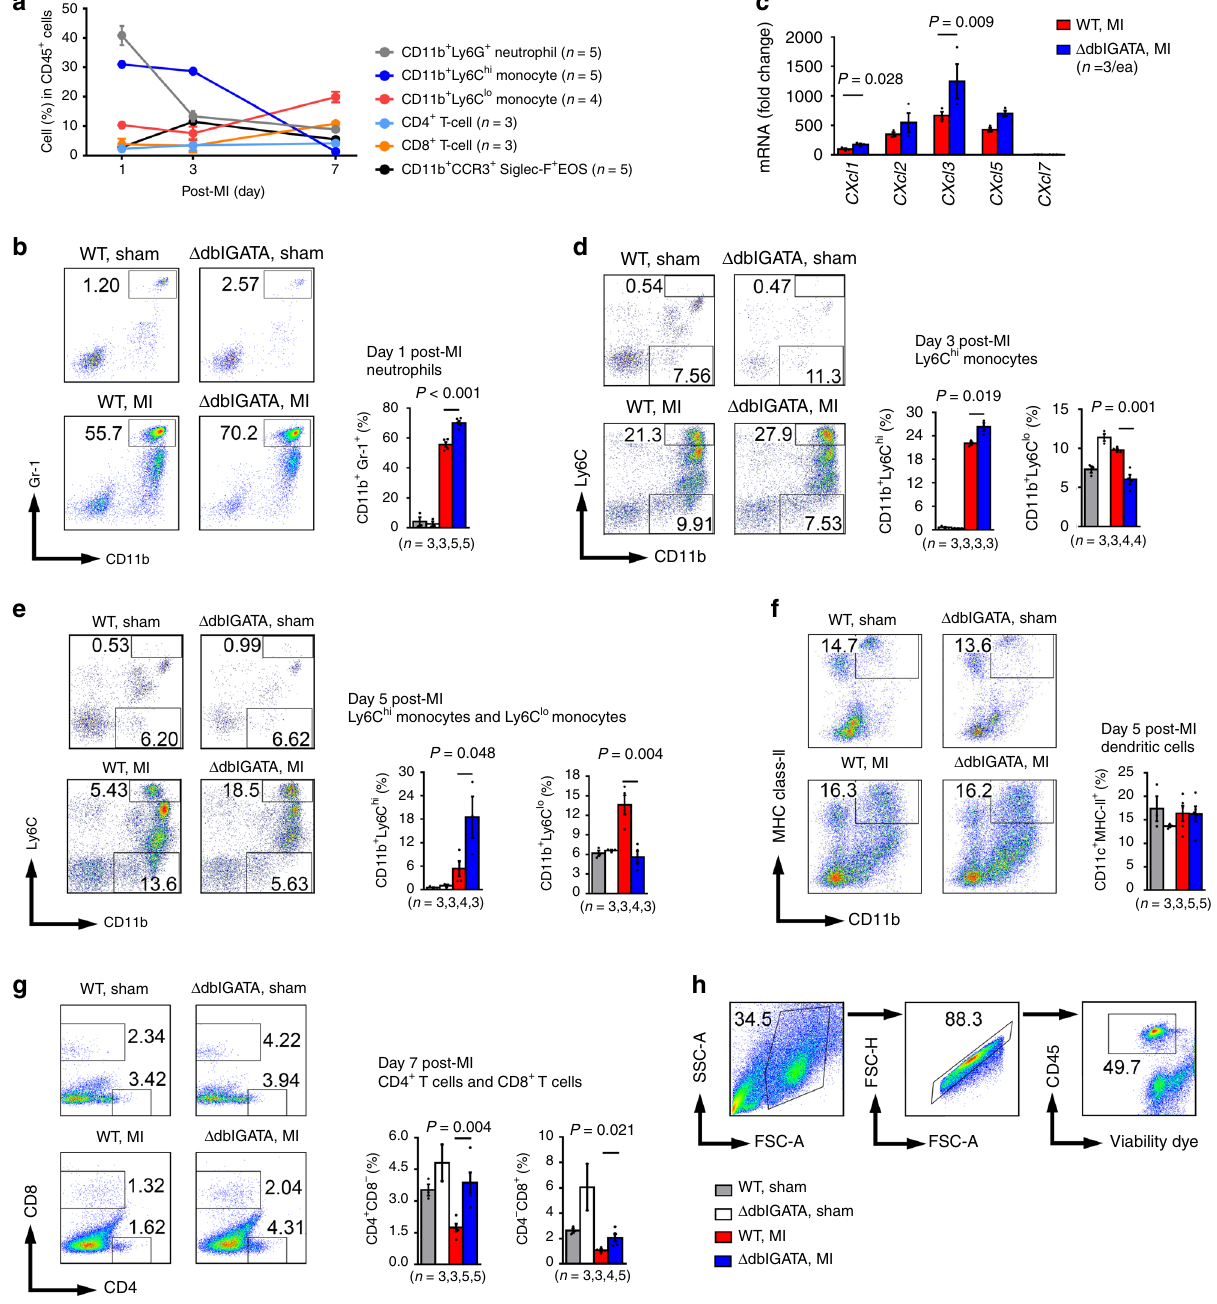
Fig. 3 EOS de fi ciency affects heart acute immune cell accumulation post-MI. a FACS quanti fi cation of different immune cells in percentage of total CD45 + cells at different time points post-MI. b CD45 + CD11b + Gr-1 + neutrophils at 1-day after surgery. c RT-PCR determined the mRNA levels of neutrophil relevant chemokines (Cxcl1, Cxcl2, Cxcl3, Cxcl5, Cxcl7) in heart from WT and Δ dblGATA mice at 1-day post-MI. d, e CD45 + CD11b + Ly6C hi and CD45 + CD11b + Ly6C lo monocytes at 3 days ( d ) and 5 days ( e ) after surgery. f CD45 + CD11c + MHC-II + dendritic cells at 5 days after surgery. g CD45 + CD4 + CD8 – and CD4 – CD8 + T cells at 7 days after surgery. h FACS gating strategy. Data are mean ± SEM. The numbers of mice in each experimental group and P values are indicated, one-way ANOVA test ( b , d – g ) and non-parametric Mann – Whitney U test ( c at 5 days post-MI than 3 days post-MI, Δ dblGATA hearts still shown in Fig. 3h. At 1-month post-MI, we measured splenic showed greater numbers of Ly6C hi monocytes than WT hearts, in fl ammatory cells. Splenic neutrophils remained higher in Δ dblGATA mice than in WT mice post-MI (Supplementary and Δ dblGATA hearts had reduced levels of Ly6C lo monocytes (Fig. 3e). At 5 days and 7 days post-MI, we measured dendritic Fig. 1a). As in the heart, Δ dblGATA mice had higher levels of cells, and CD4 + and CD8 + T cells. Dendritic cell numbers did post-MI splenic total TNF- α + in fl ammatory cells, TNF- α + CD4 + , not differ between WT and Δ dblGATA hearts, but Δ dblGATA TNF- α + CD8 + T cells, and total CD4 + and CD8 + T cells than WT mice (Supplementary Fig. 1b – e). Yet, data showed hearts contained more CD4 + and CD8 + T cells than WT mouse hearts (Fig. 3f, g). Heart immune cell FACS gating strategy is signi fi cantly reduced splenic CD45 + CD4 + CD25 + Foxp3 + T